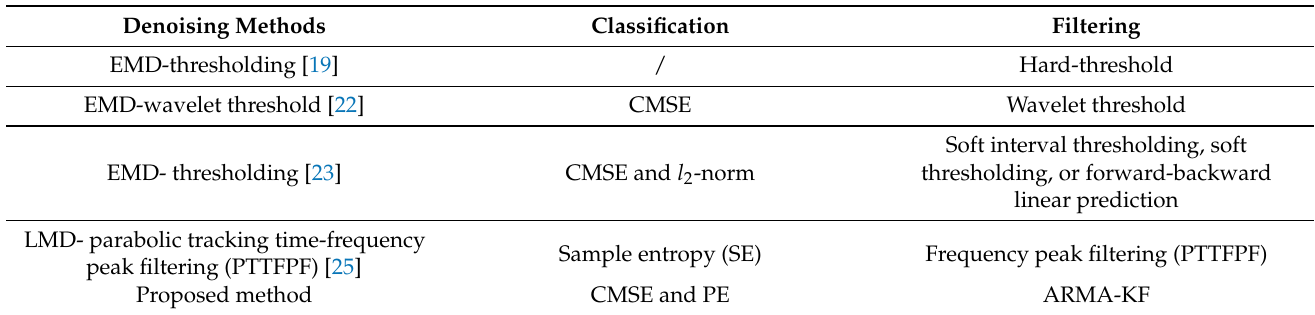
Table 1. Comparison of denoising